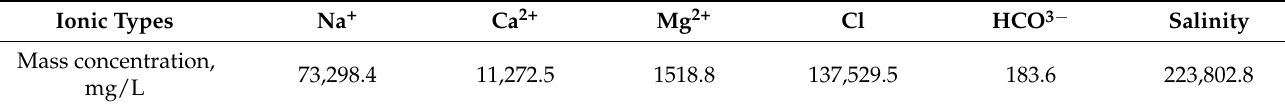
Table 1. Salinity table of the formed water solution.